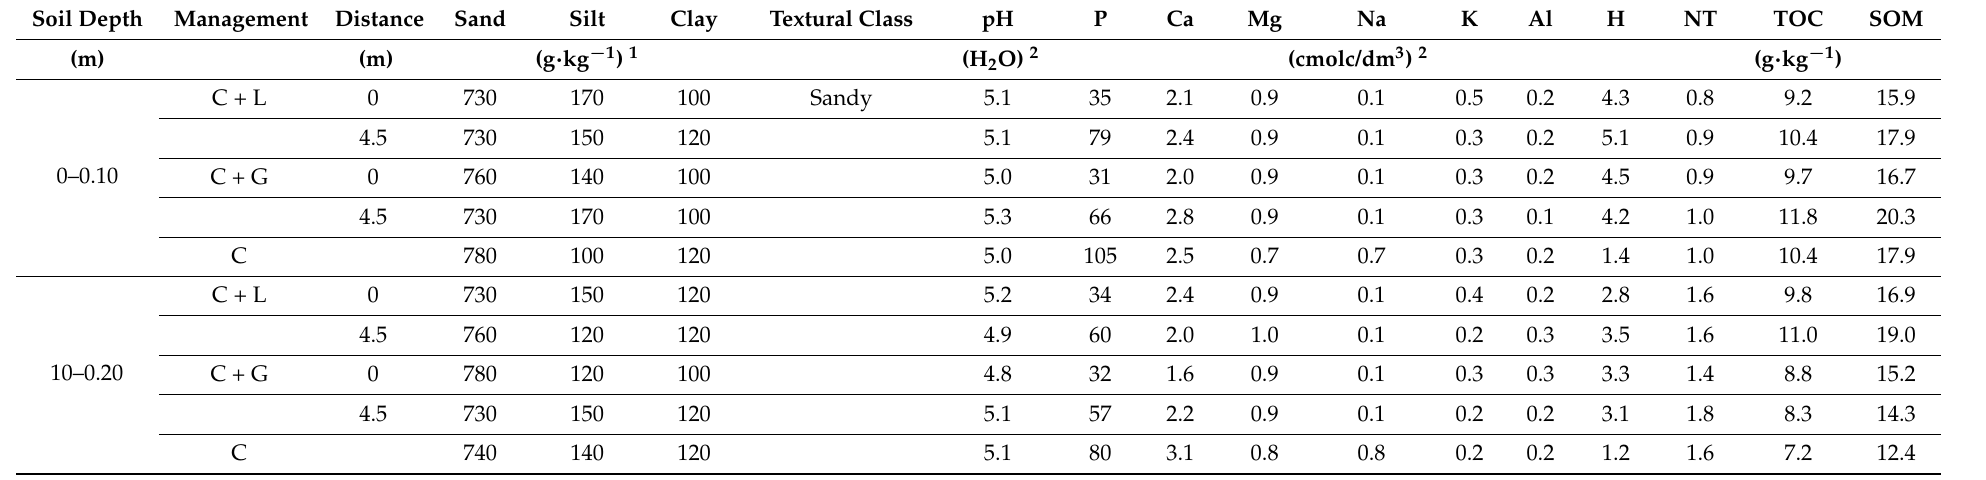
Table 1. Soil chemical and physical characteristics at the beginning of the experiment